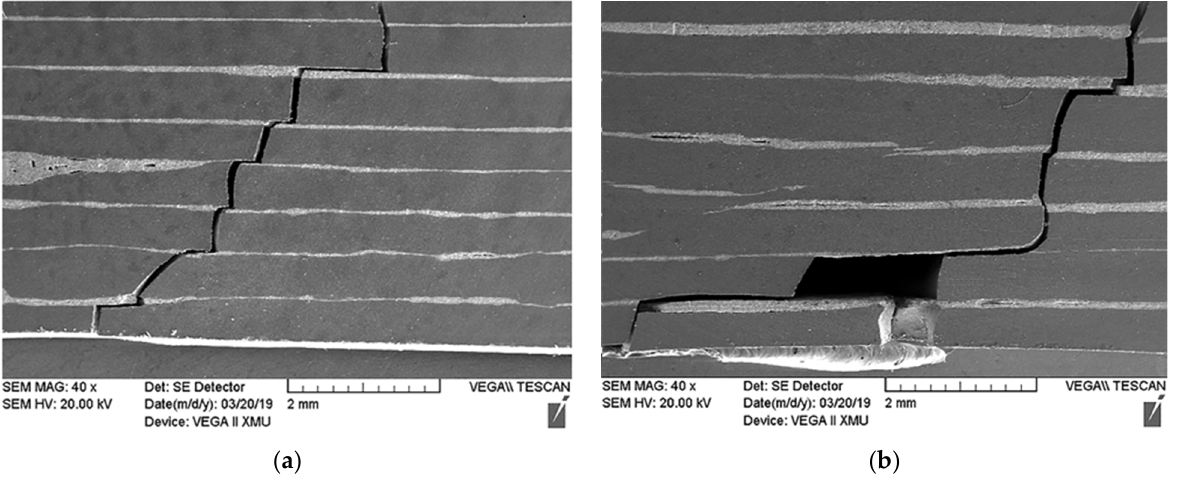
Figure 7. The fracture trend of Si 3 N 4 /Mo laminated ceramic composites: ( a ) 9SM; ( b ) 11SM. The tribological characteristics of the laminated composite were also carried out, and the friction coefficients and wear rates of Si 3 N 4 /Mo-laminated composite sliding against TC4 pairs at different load in seawater are shown in Figure 8. From this figure, it can be seen that the friction coefficients of the sliding pairs increase with the increase in load (from 10 N to 30 N) in Figure 8a. In general, the friction coefficient of laminated composite/TC4 is at a range from 0.3 to 0.5, and the friction coefficient of 9SM/TC4 pair is highest. From Figure 8b,c, the wear rates of pin and disc both increase with the increase in load. Additionally, the wear rates of laminated composite/TC4 pair are higher than the single ceramic/TC4 pair. Combined with the results of friction coefficient and wear rate, it can be seen that adding Mo as the interfacial layer to the Si 3 N 4 ceramic matrix did not improve its tribological properties.